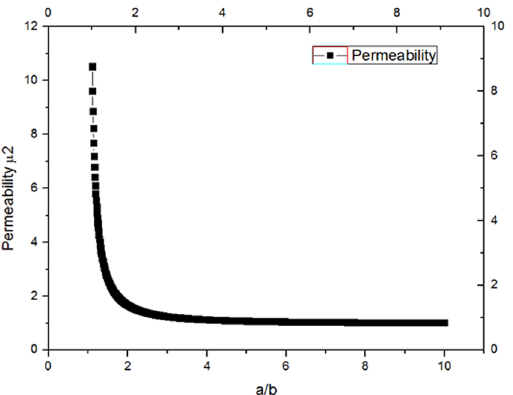
Figure 3. The distributions of the magnetic field and induced electric field in the center line (y = 0, z = 0, green line in insert). The seven black segments (indicated by black arrows) are the distributions of the magnetic field and the five red segments (indicated by red arrows) are the distributions of the induced electric field. The magnetic field and induced electric field are symmetry about x = 0, the electric and the magnetic field are not continuous on the boundaries x = ± 0.025 m, x = ± 0.020 m, x = ± 0.010